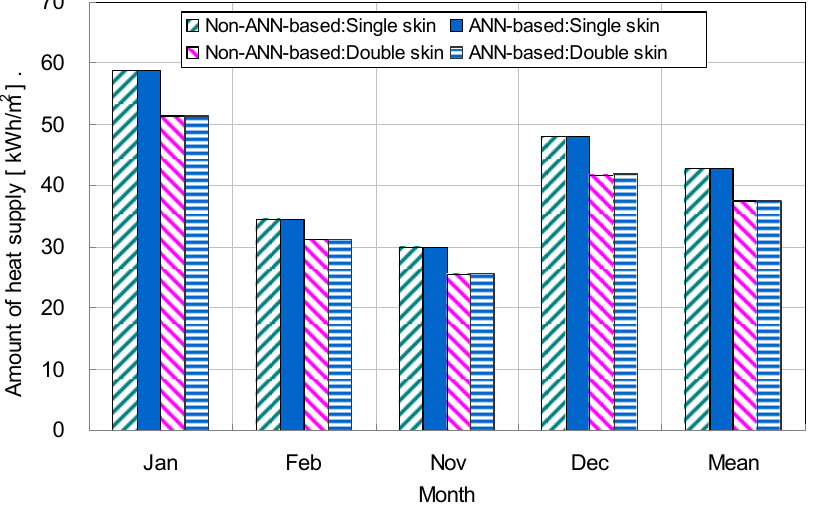
Figure 14. Amount of heat supply by four control